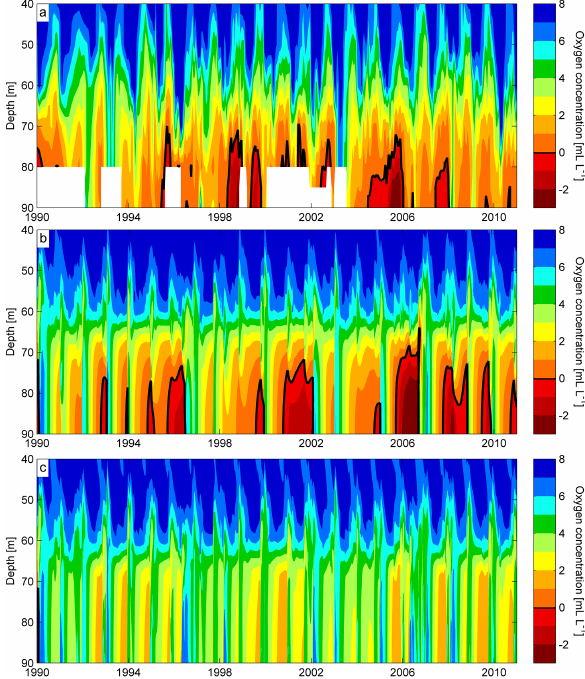
Figure 7. (a) The measured oxygen content from BY4, (b) the mod- eled oxygen content (reference run) and (c) the modeled oxygen content when pumping 1000m 3 s − 1 from 30m depth down to